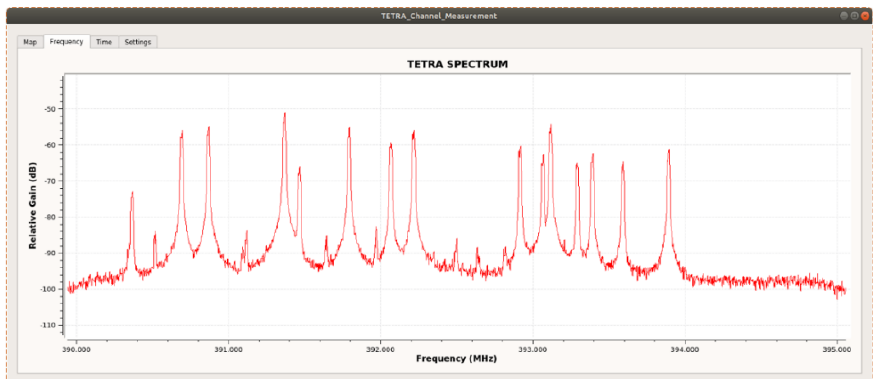
Figure 14. Downlink spectrum of TETRA channels measured in a field location by the ADALM Pluto SDR platform.